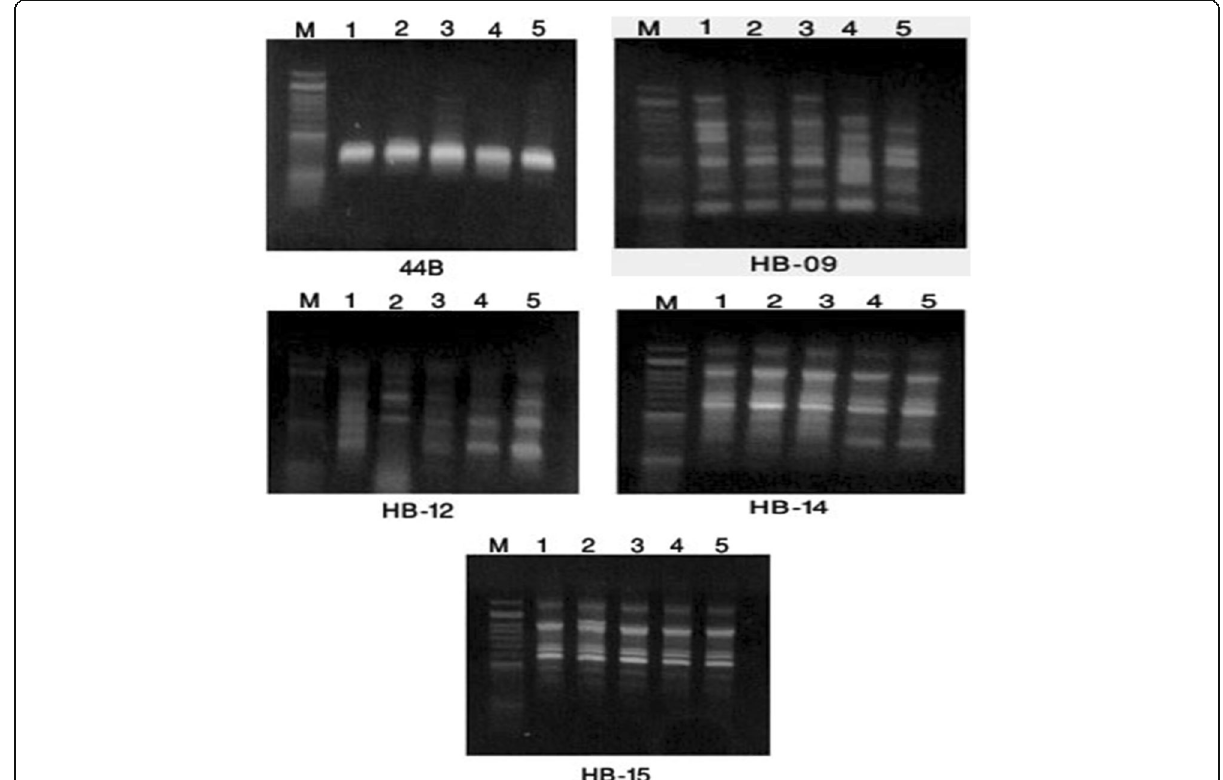
Fig. 2 ISSR profile of five cultivars of Coleus generated by 5 primers, M, DNA Marker; 1, Color Clouds spicy, 2, Beckwhites gem; 3, solar red, 4, Colorblaze alligtore tears; 5, finger paint